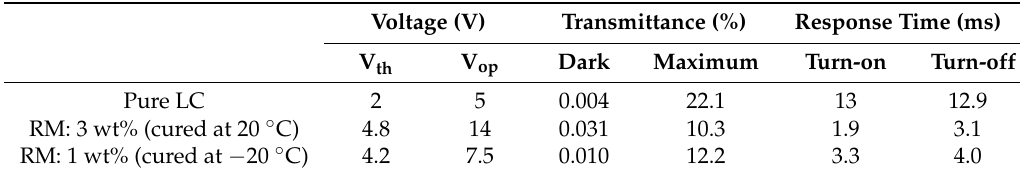
Figure 4. Normalized V-T curves of IPS cells fabricated by curing 1 and 3 wt% of RM at 20 °C, and 1 wt% of RM at − 20 °C.